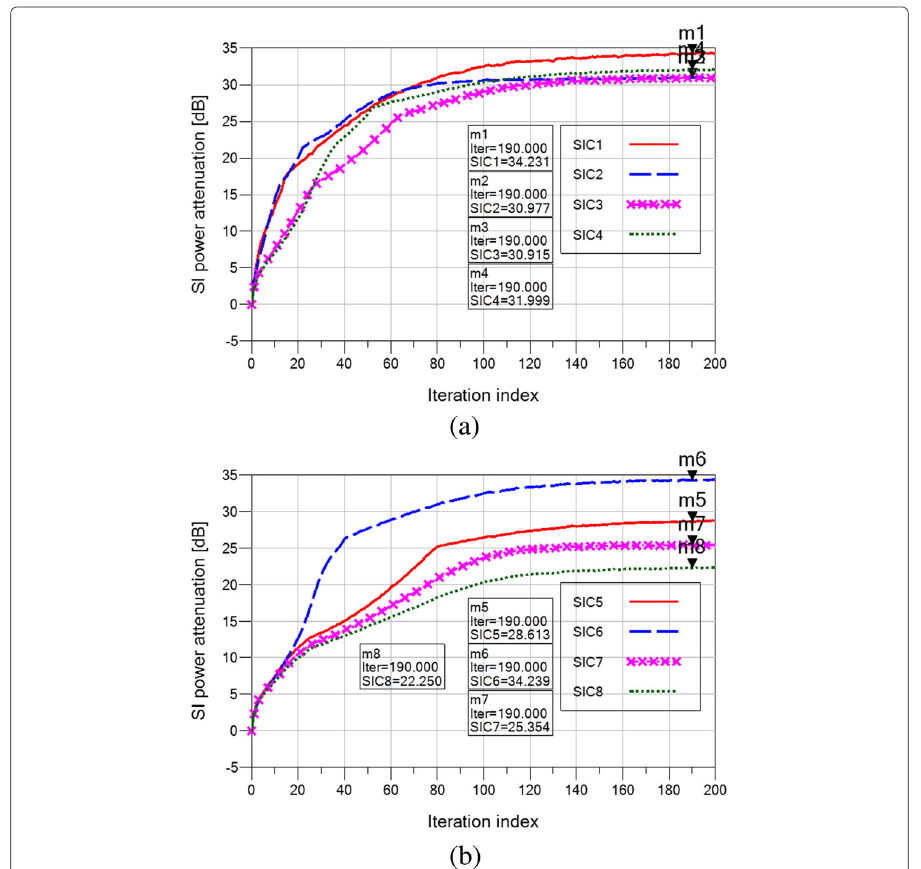
Fig. 5 Additional SI cancelation provided by the RF canceler when the antenna isolation without reflections is 61 dB: a SI channel delay smaller or equal to RF canceler delay, b SI channel delay longer than RF canceler